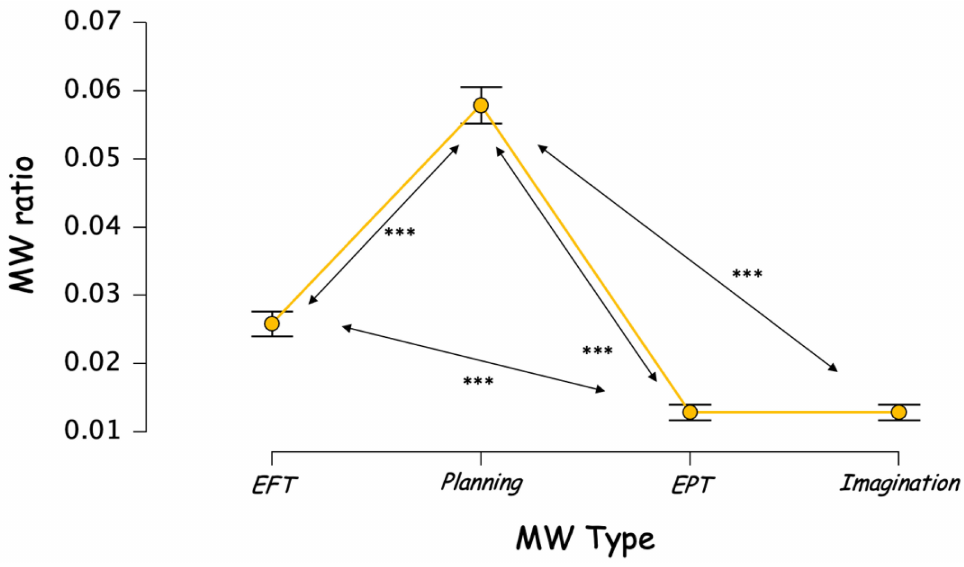
Figure 3. Frequency of different MW contents, calculated on all thought probes. *** p < 0.001. There was also a significant main effect of the MW source, F(2,450) = 6.520, p = 0.002, η p2 = 0.028 (Figure 4). A post hoc analysis, with Bonferroni correction, showed that the source of the mind wandering episodes was more Spontaneous (0.031, 95% CI [0.027; 0.034]) than External (0.025, 95% CI [0.022; 0.029]) and Voluntary (0.026, 95% CI [0.023; 0.030]). The